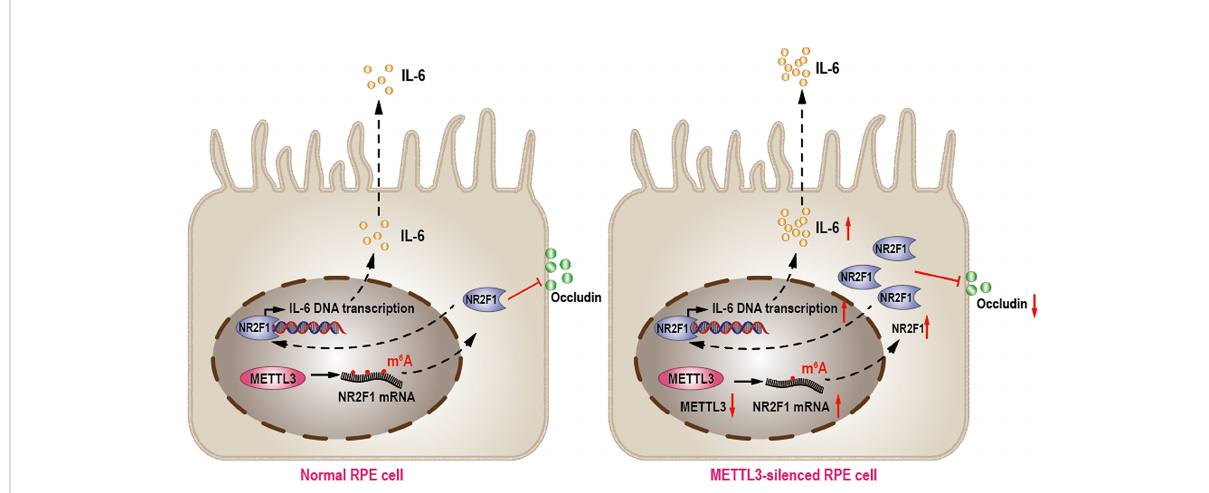
FIGURE 6 METTL3 regulates RPE in fl ammation by NR2F1 in an m 6 A-dependent manner. In normal RPE cell, METTL3 methylates NR2F1 and then decreases protein level of NR2F1, which lead to reduced IL-6 transcription and secretion but increased Occludin expression (Left). In METTL3-silenced RPE cell, NR2F1 is increased and then promotes IL-6 secretion but inhibits Occludin expression, which fi nally lead to increased in fl ammation